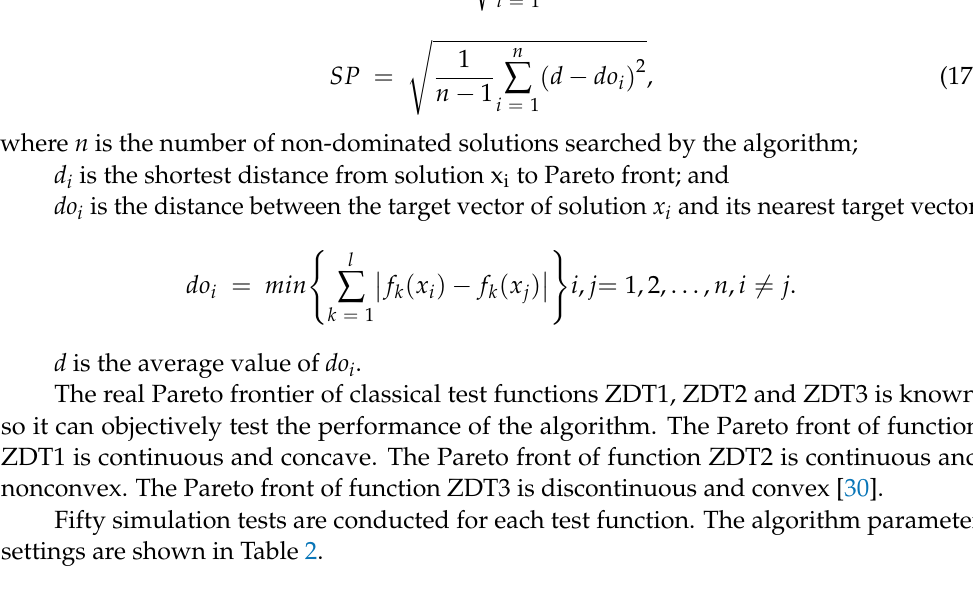
Table 2. Parameters of algorithms.